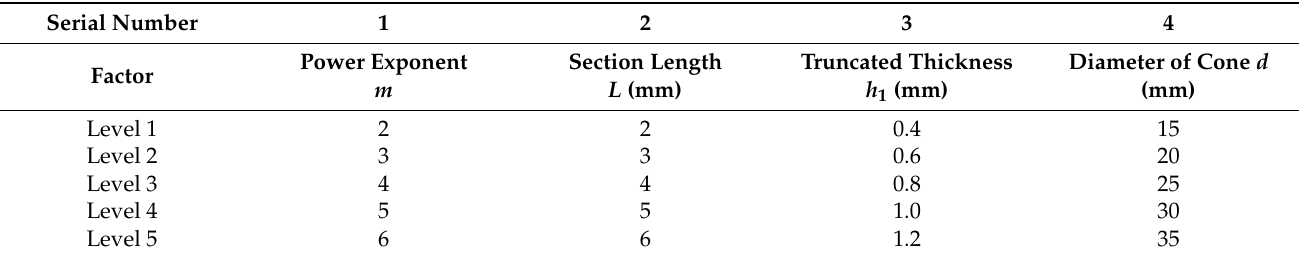
Table 5. Orthogonal test table of ABH structure.